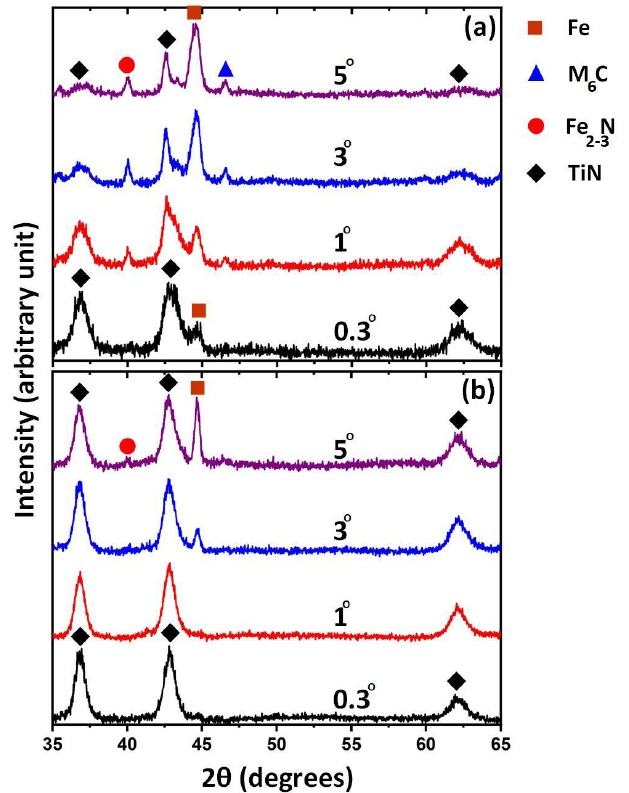
Figure 3. Grazing incidence X-ray diffraction of duplex-treated samples with substrate temperature for TiN deposition at ( a ) 400 °C and ( b ) 450 °C. The surface SEM images of base material and nitrided and duplex-treated samples are shown in Figure 4. The base surface (Figure 4a) contains polishing scratches induced by the mechanical polishing of samples before plasma processing. The surface of the ni- trided sample (Figure 4b) contains uniformly distributed polygonal iron nitride particles, following the literature [7]. The surface of the duplex-treated samples (Figure 4c,d) con- tains uniformly dispersed spherical nanoparticles agglomerated to coralloid granular ni- trides, as shown in high-resolution images. These particles are mainly composed of Ti and N elements observed by EDS analysis (spectra are not presented here). The particles are more agglomerated for the sample treated at higher temperatures [35]. The deposition of Ti can be ascribed to the cathodic cage sputtering and its re-deposition on the sub- strate.